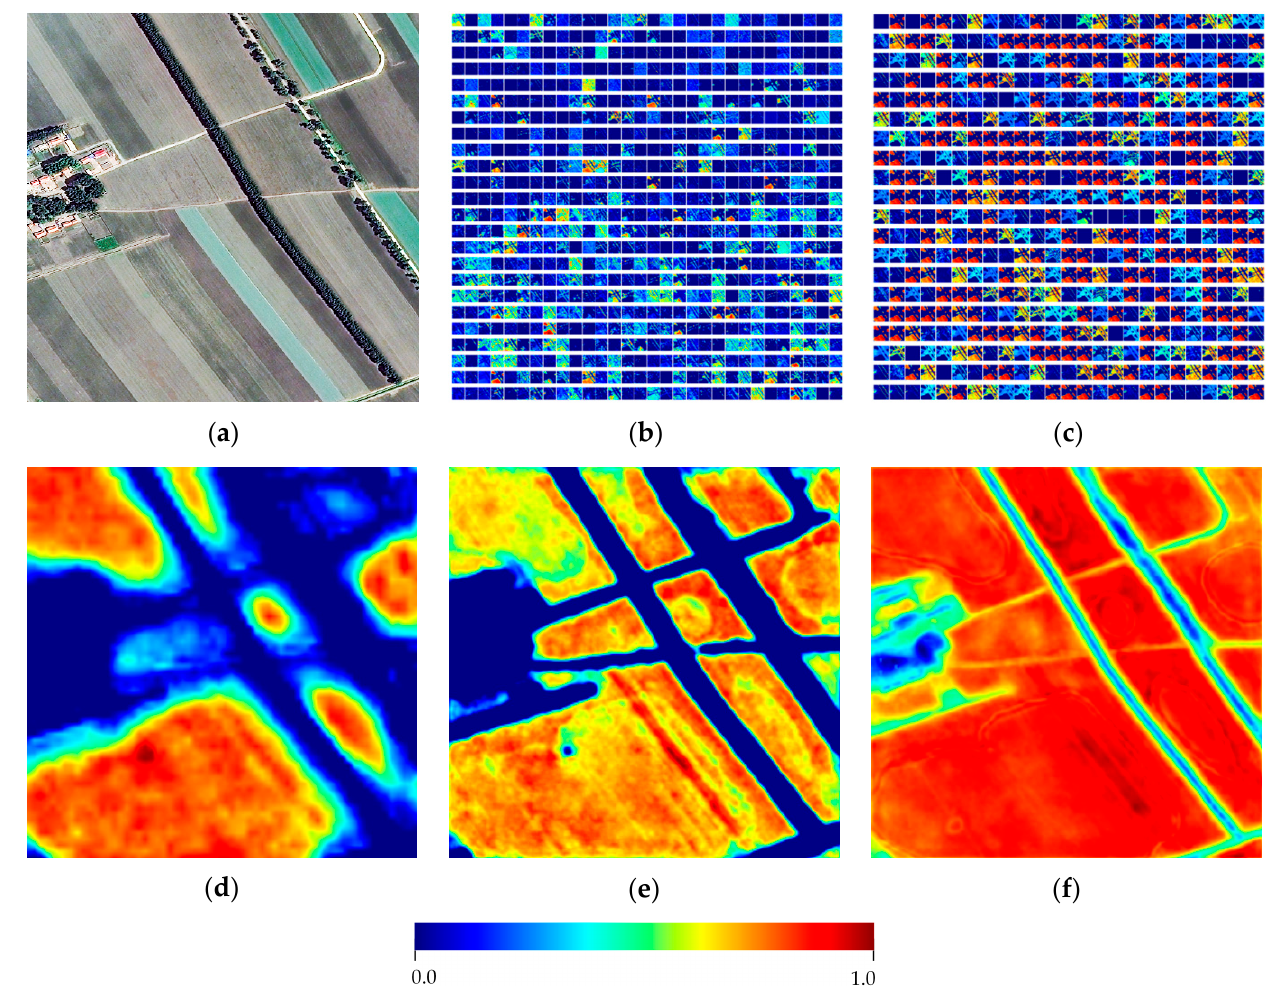
Figure 14. Visualization of the feature map of the target of interest in the image by the HRNet-CFR model. ( a ) Original true-color image, ( b ) visualization of the feature in Stage4, ( c ) visualization of the final fusion feature through CFR, ( d ) the visualization of one rich channel before CFR module processing, ( e ) the visualization of one rich channel of the CFR module, and ( f ) the probability heat map of cropland. Note: the features are normalized between 0–1. The redder the color, the more prominent the characteristics of cropland target. The bluer the color, the more prominent the other target features.